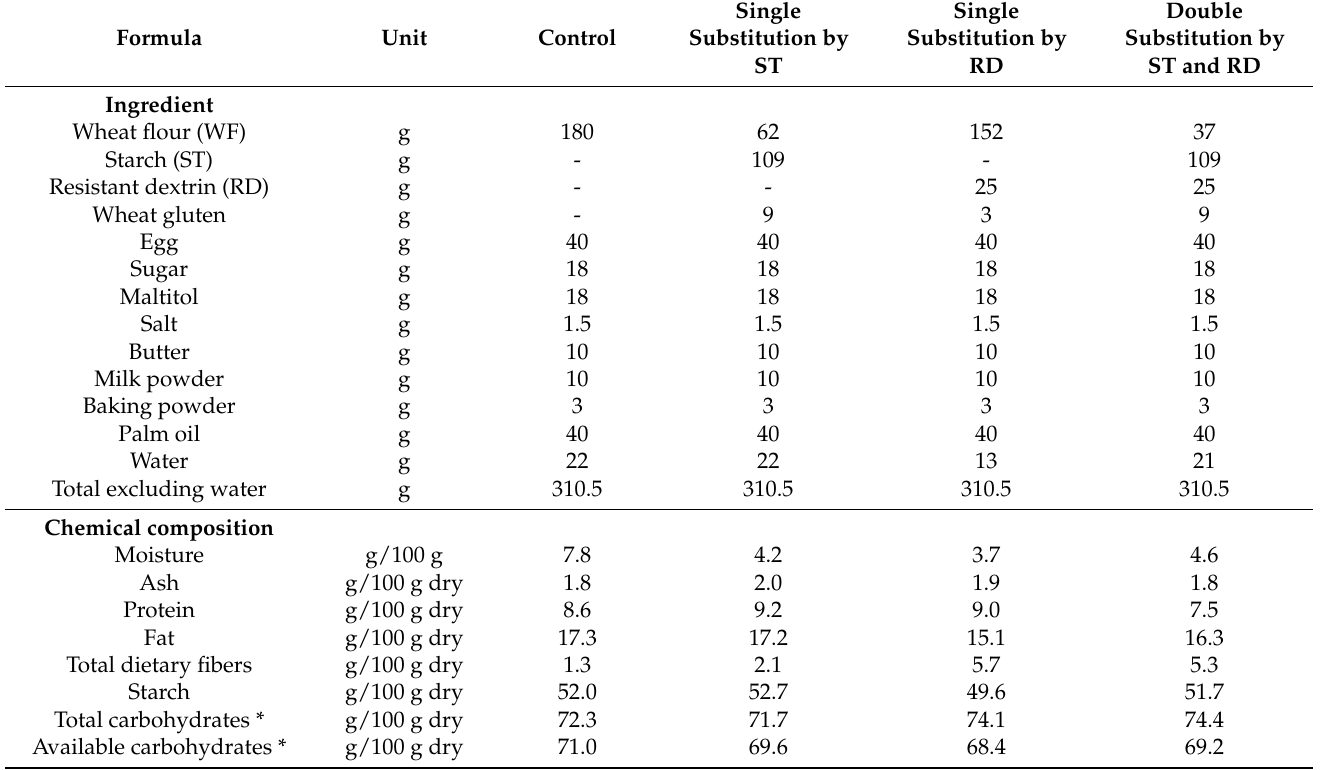
Table 1. Formulae and chemical compositions of the control and substituted